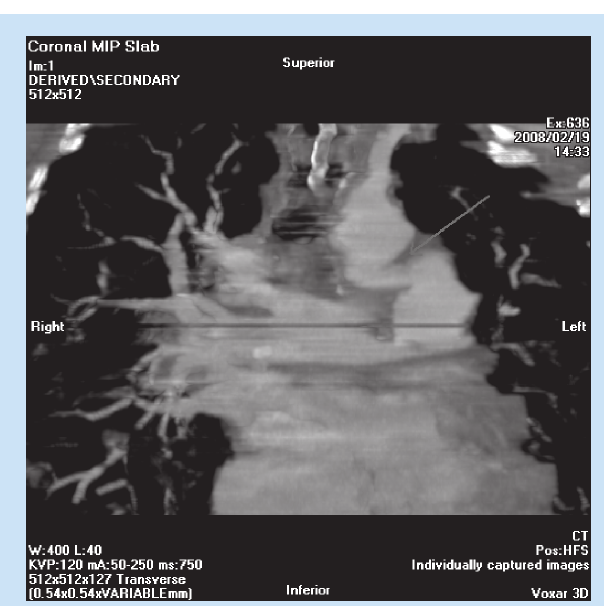
Fig. 5. Multislice spiral pulmonary angiogram: 3D reconstruction, sagittal image; arrow points to PDA.